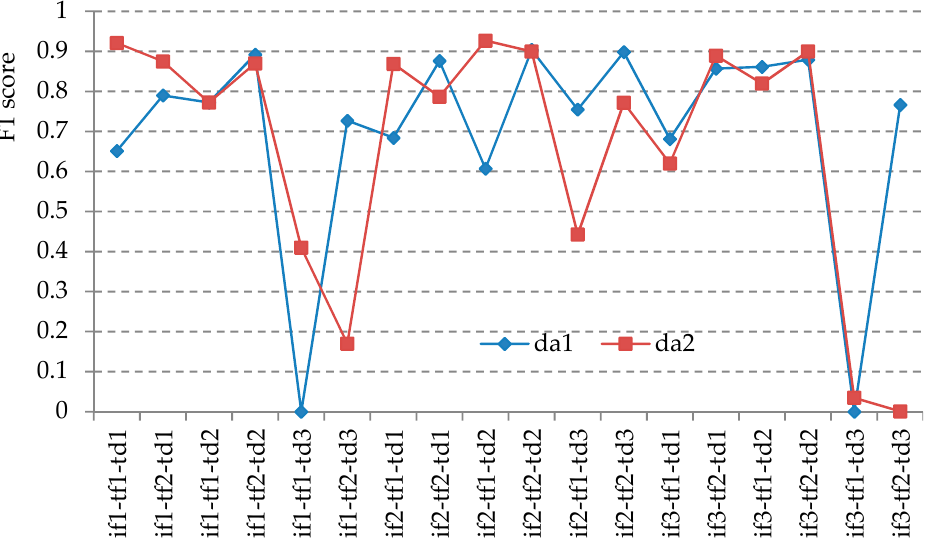
Figure 16. Average F1 scores of 10 test areas for 18 groups of models with and without data augmentation as explained in Table 2.